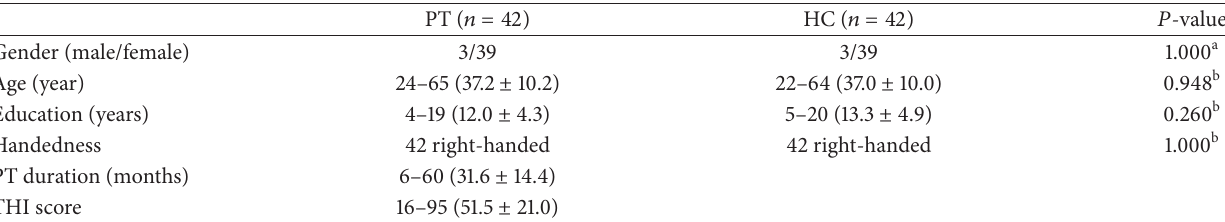
Table 1: Characteristics of the